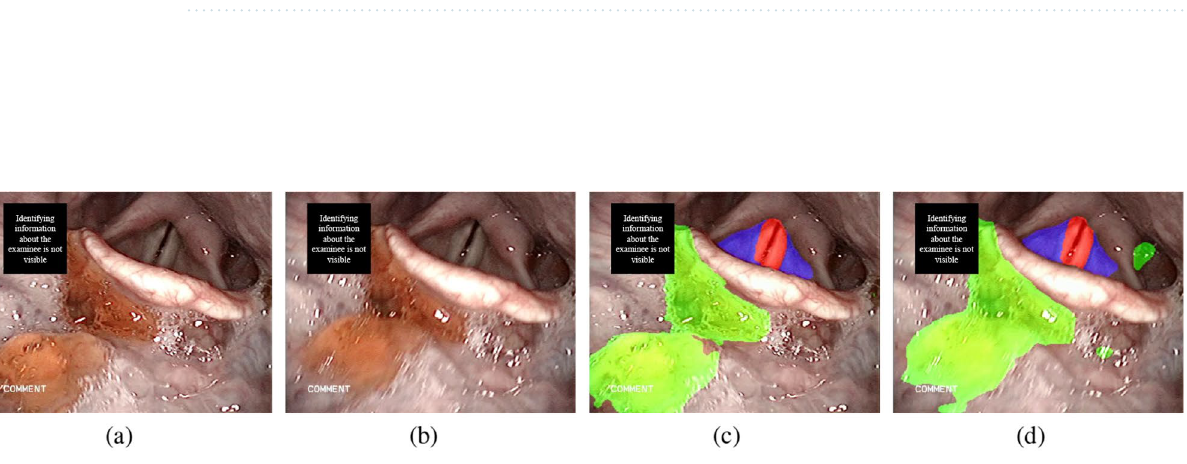
Figure 7. An example of ( a, b ) two consecutive FEES images and ( c, d ) their corresponding segmentation results.